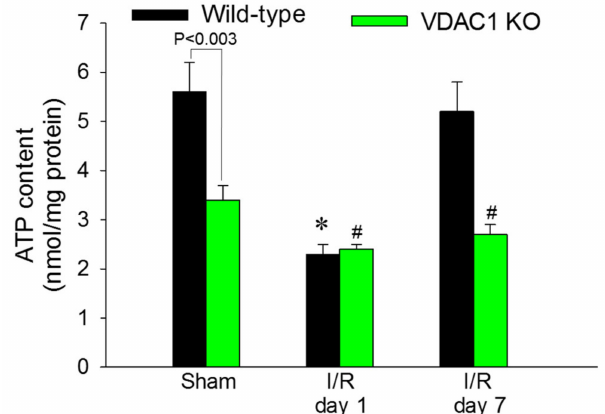
Figure 9. Deletion of VDAC1 blocks recovery of ATP content in renal cortex after ischemia-induced AKI. The content of ATP was assessed in liquid nitrogen snap-frozen renal cortical samples dissected immediately after euthanasia from kidneys of wild type (WT) and VDAC1-deficient (VDAC1 KO) mice on days 1 and 7 after bilateral renal ischemia (35 min). Results are the average ± S.E. of data obtained from eight WT and 11 VDAC1 KO mice. * Values significantly di ff erent ( p < 0.05) from respective WT sham-operated mice. # Values significantly di ff erent ( p < 0.05) from respective kidneys of VDAC1 KO sham-operated